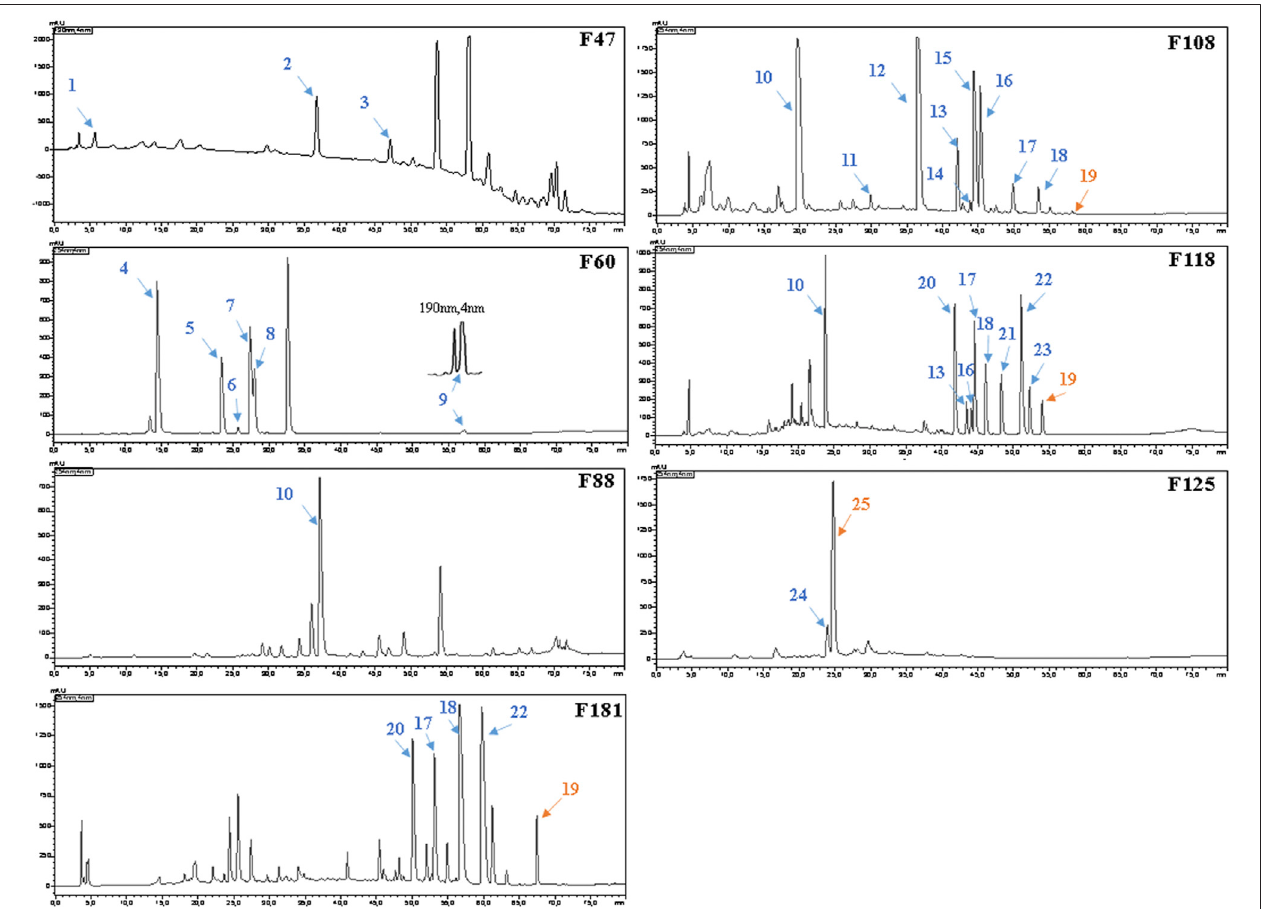
FIGURE 3 | HPLC – UV chromatograms and active peaks of the selected fractions from the stem of Picrasma quassioides . The peaks active against S. aureus are marked in blue, while the ones active against both S. aureus and E. coli are numbered in orange.